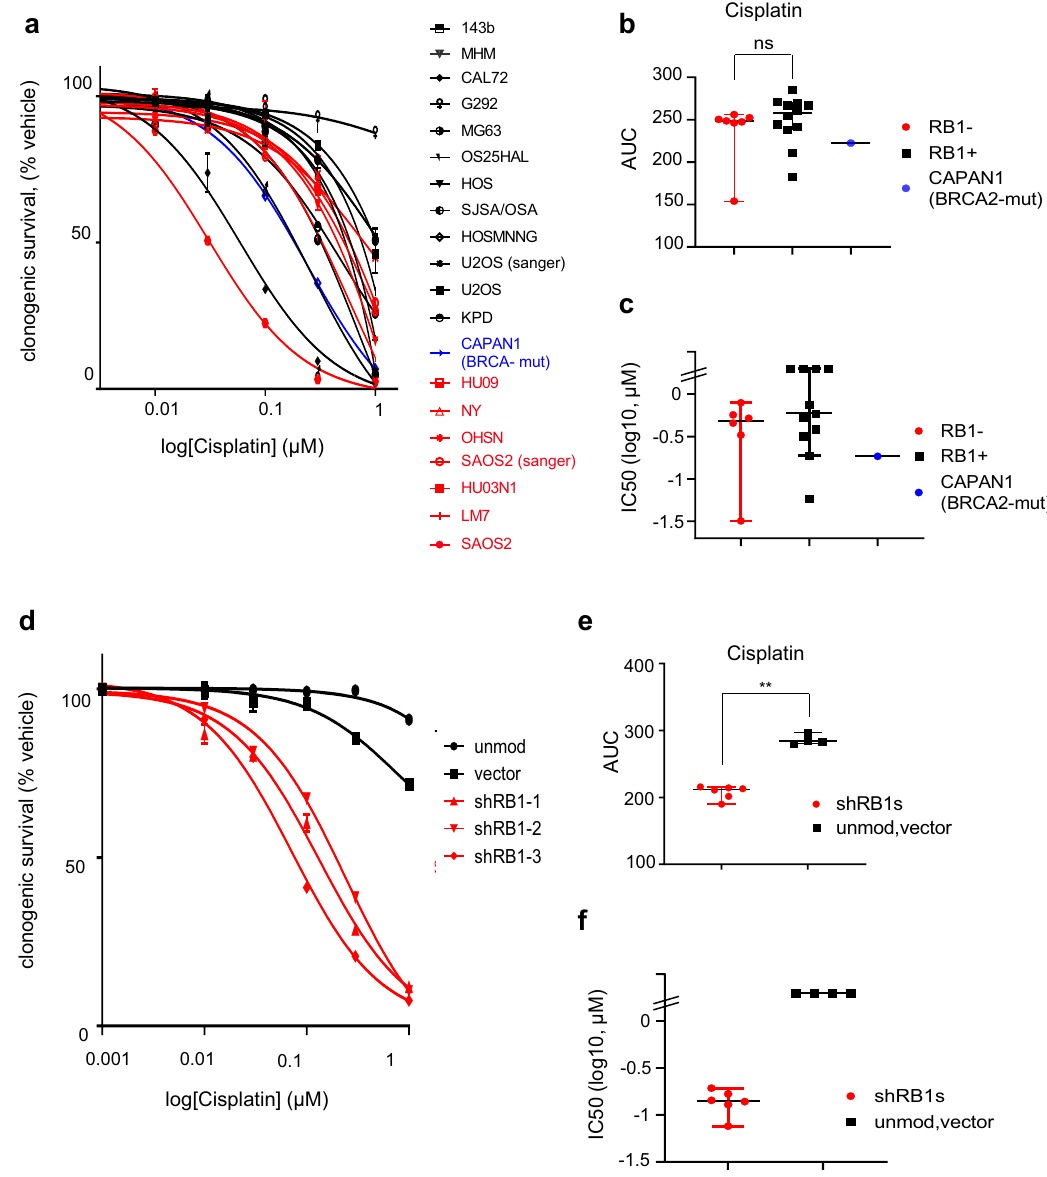
Fig. 6 Platinum sensitivity in RB1-defective osteosarcoma. Cells seeded at low density into six-well plates were cultured in the presence of increasing concentrations of cisplatin or vehicle (DMSO). Colonies arising were stained using crystal violet dye. Clonogenic survival was quanti fi ed using dye extraction. a – c Platinum response in RB1-defective (red) or RB1-normal (black) osteosarcoma and BRCA2 -mutant CAPAN1 (blue). a Concentration- response curve and b scatter plots depicting AUC value comparison and c log IC50 values, deduced from the concentration-response data in a . Bars in scatter plots ( b , c ) depict median (±95%CI), calculated using a two-tailed Mann – Whitney test, p ( b ) = 0.3730 ns . Data points in a – c re fl ect the mean of parallel duplicate wells for n = 1 dataset. d – f RB1-normal osteosarcoma CAL72 cells transduced with lentivirus vector encoding different RB1 -targeting shRNAs (shRB1-1, shRB1-2 or shRB1-3) (red), or empty vector backbone (vector), or left unmodi fi ed (unmod) (black). d Concentration-response curve, e scatter plots depicting AUC value comparison and f log IC50 values, deduced from the concentration-response data in d . Bars in scatter plots ( e , f ) depict median ±95%CI. Data in d depict means of parallel duplicate wells for one of n = 2 biologically independent datasets, data in e and f summarise results for n = 2 biologically independent datasets. p ( e ) = 0.0095, calculated using a two-tailed Mann – Whitney test, ** p < 0.01. Source data are provided as a Source Data fi